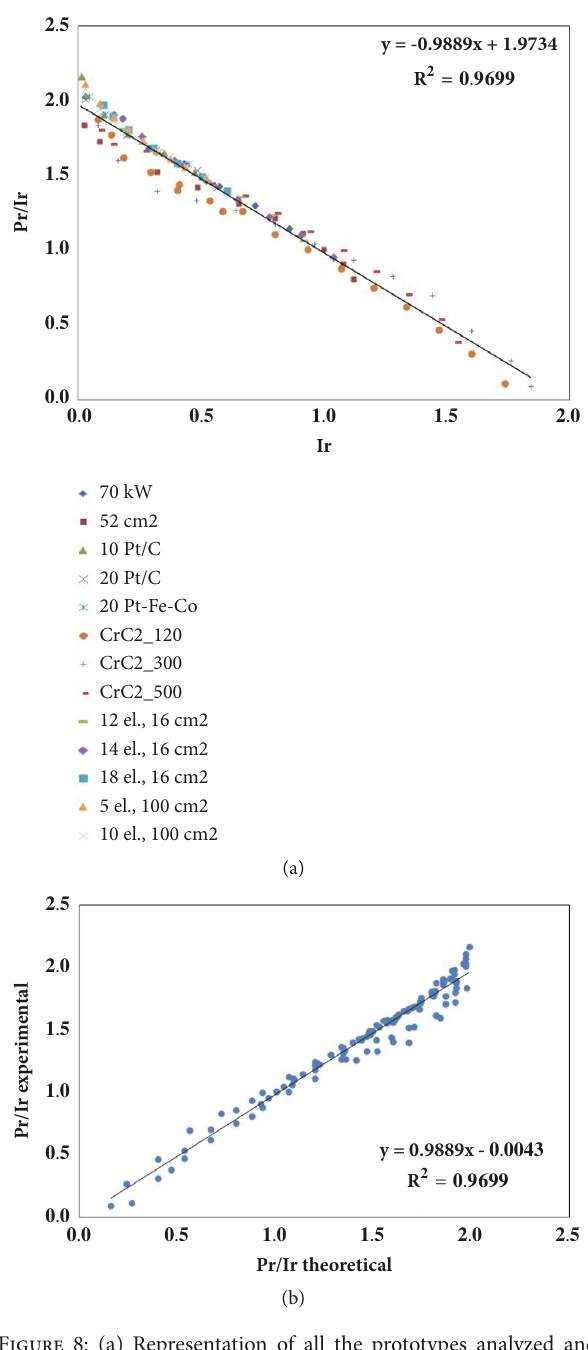
Figure 8: (a) Representation of all the prototypes analyzed and (b) experimental results as a function of theoretical results of the quotient between relative power and relative current